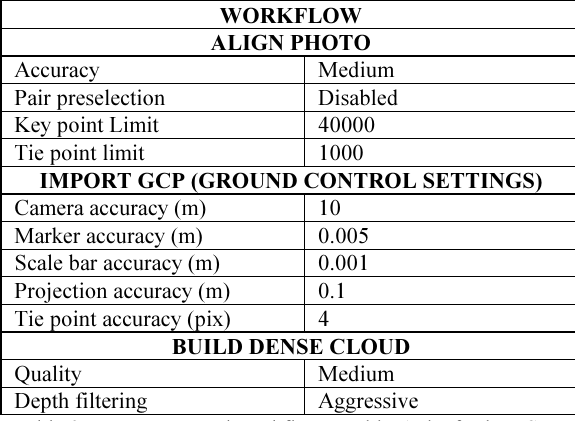
Table 3: Parameters and workflow used in Agisoft PhotoScan